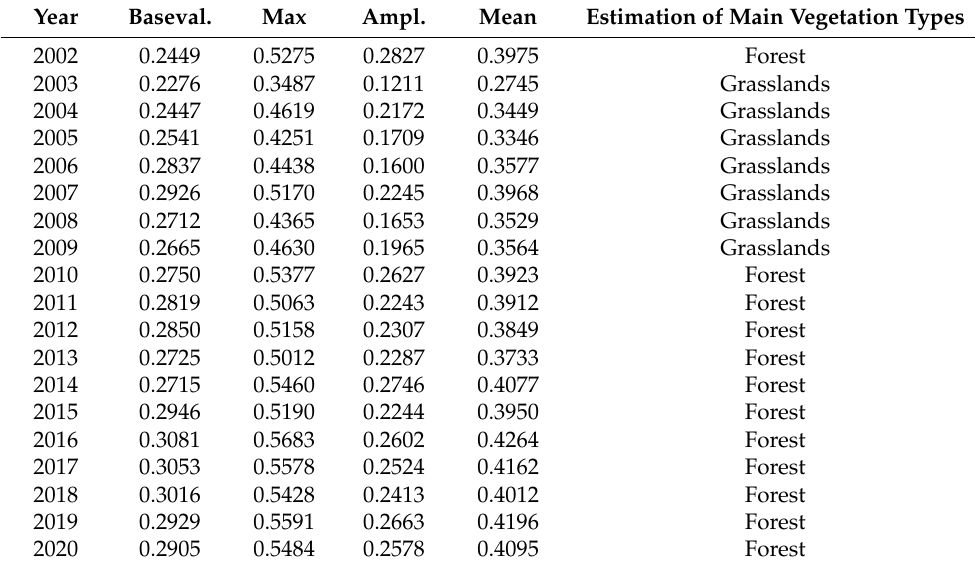
Table 7. Typical land cover phenological parameters of Zone 2.